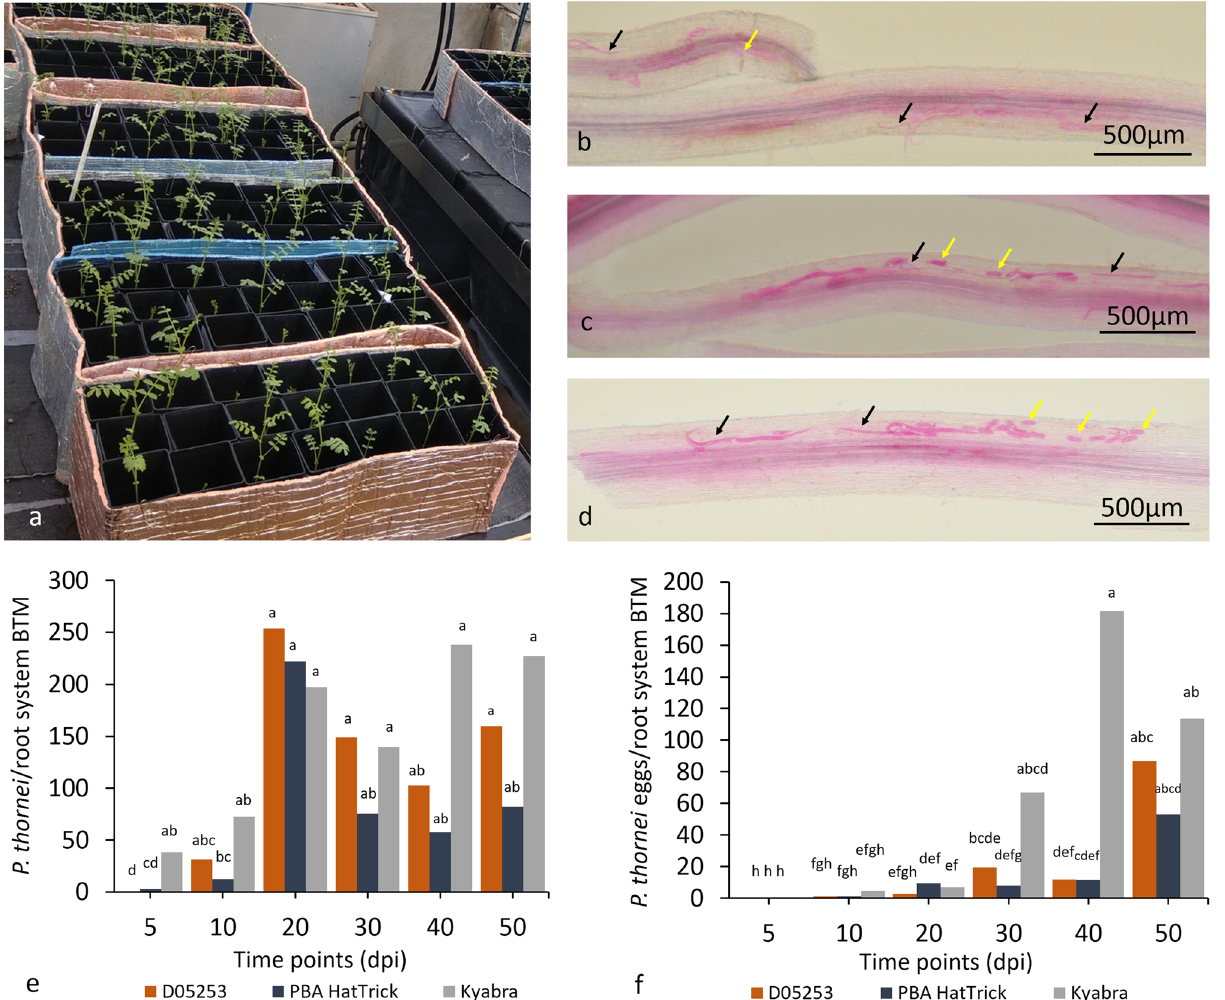
Figure 1. Phenotypic evaluation of Pratylenchus thornei infection of three chickpea genotypes D05253 (D), PBA HatTrick (H) and Kyabra (K) ( a ) Chickpea plants 5 days post inoculation (dpi) growing in the glasshouse. Roots stained with acid fuchsin at 50 dpi for chickpea genotypes ( b ) D05253, ( c ) PBA HatTrick, and ( d ) Kyabra, showing nematodes (black arrows) and eggs (yellow arrows). Time course from 5 to 50 dpi showing ( e ) Pratylenchus thornei /root system back transformed means (BTM), and ( f ) P. thornei eggs/root system back transformed means. Letters indicate l.s.d ( P = 0.05) for mean transformed values ln( x +